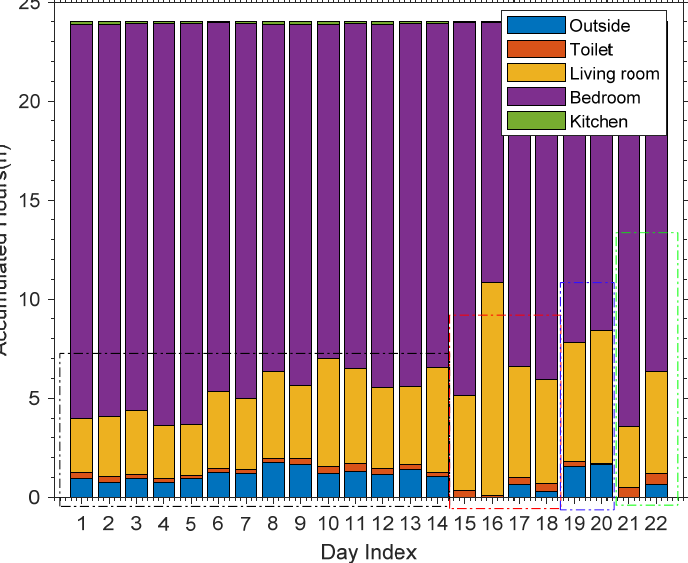
Figure 19. The accumulated hours of area occupation of all volunteers.